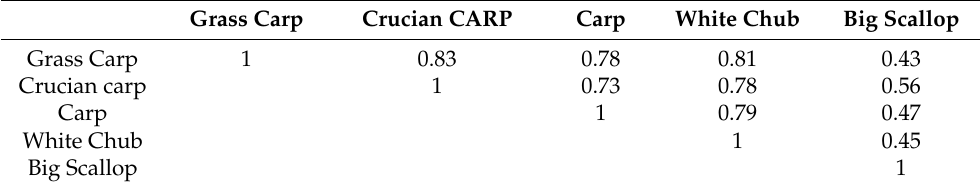
Table 2. Correlation coefficients for